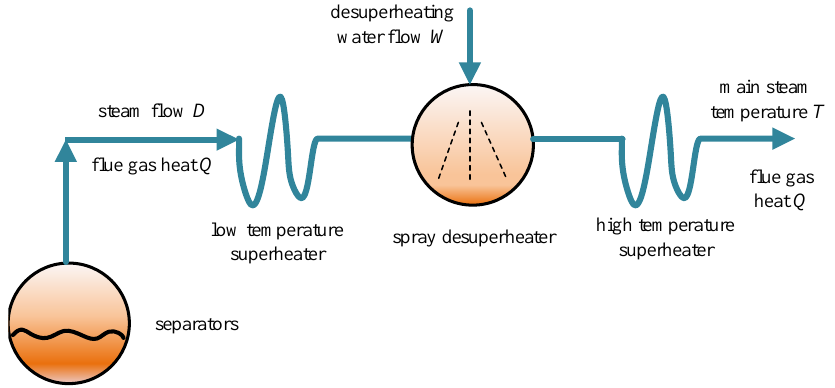
Figure 1. Schematic diagram of the structure of the secondary de-superheating water.